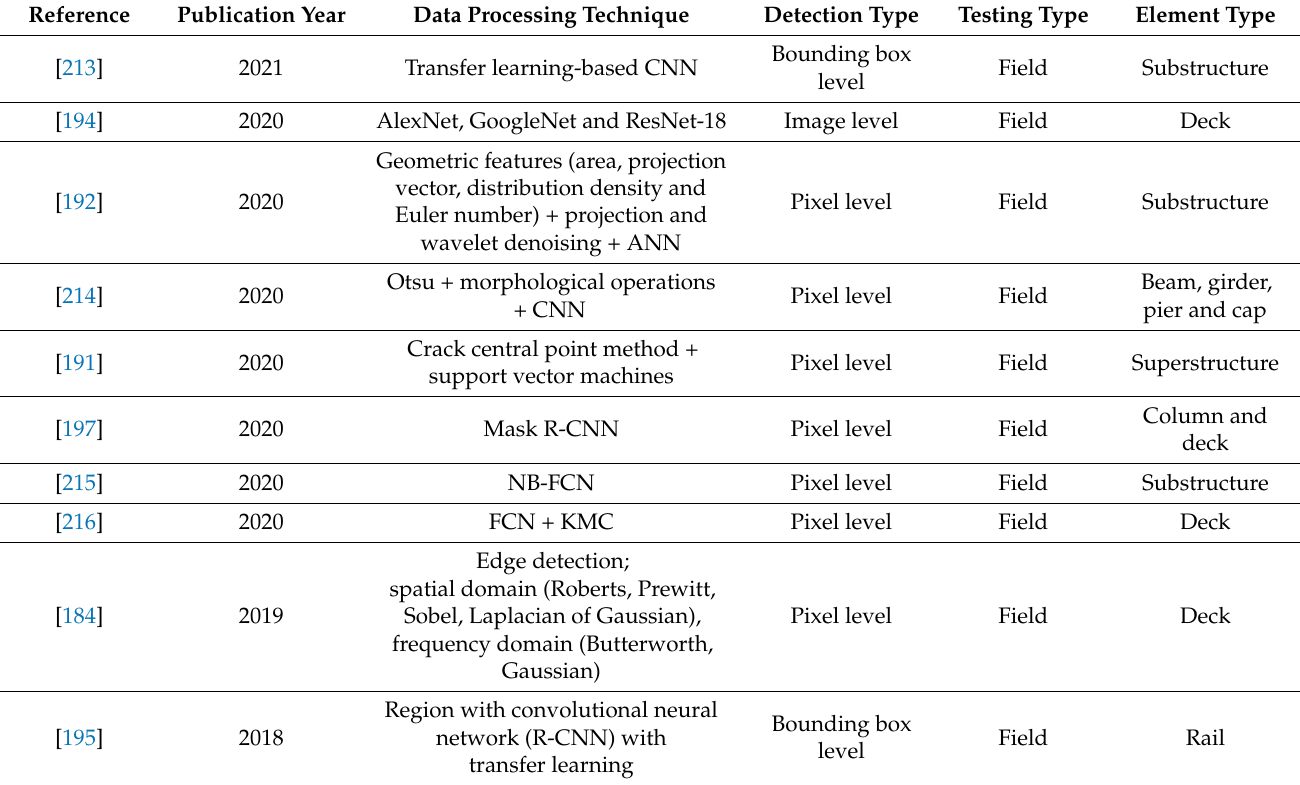
Table 17. Summary of some of the research studies for detection of surface cracks using digital photogrammetry (Cont’d).